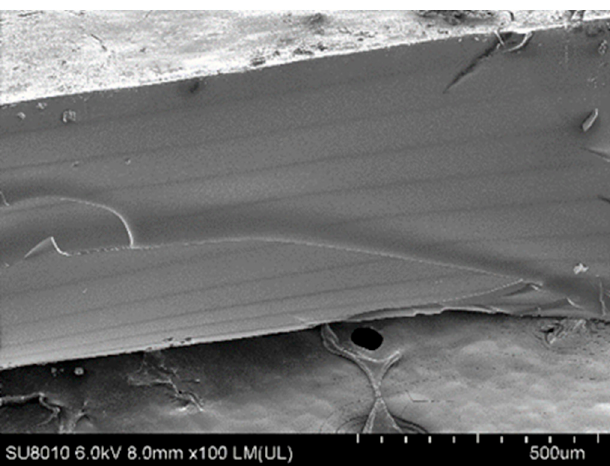
Figure 7. SEM imaging of the cross-section of a 10 layer DLP-AM printed PGSA30 scaffold.